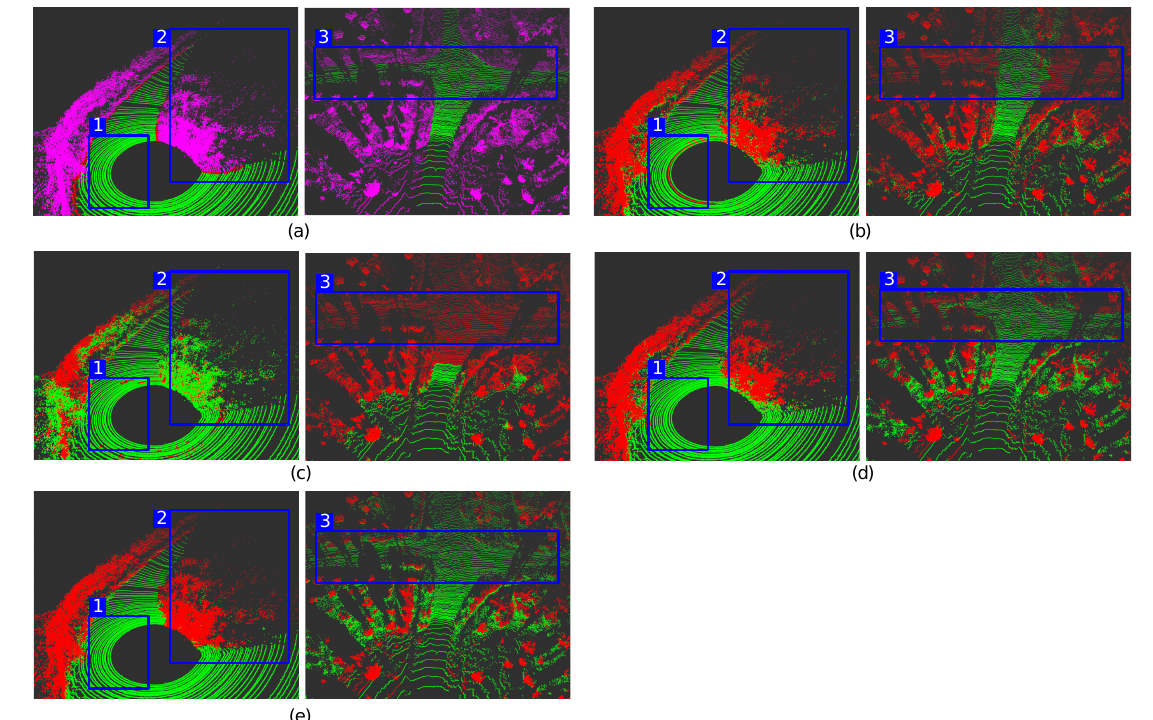
Figure 11. The ground segmentation effect of different methods on unstructured road. ( a ) Benchmark; ( b ) Chu [15]; ( c ) Bogoslavskyi [23]; ( d ) Huang [34]; ( e ) Ours. (It is recommended to zoom in to see the